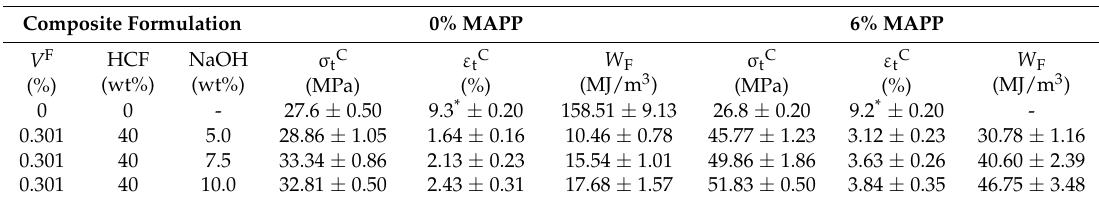
Table 2. Tensile strength, strain at break and work to fracture of the hemp core fiber (HCF)-reinforced polypropylene (PP)